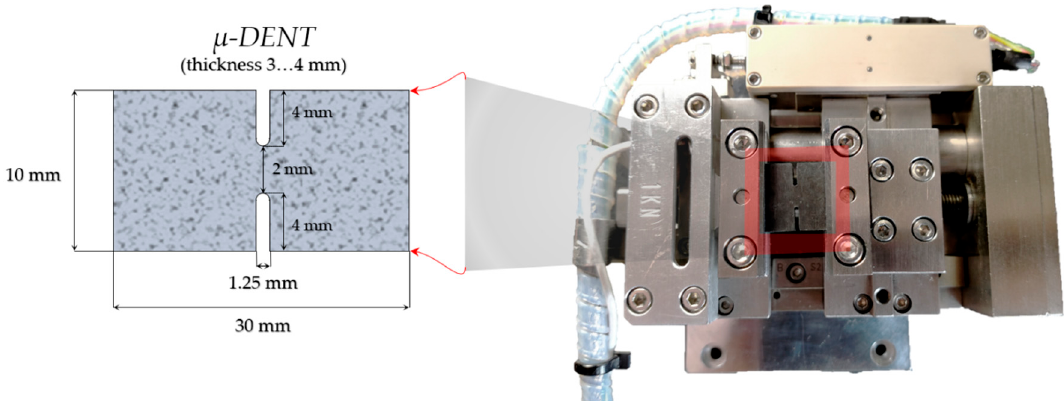
Figure 10. The shape and dimensions of double-edge notched tensile (DENT)